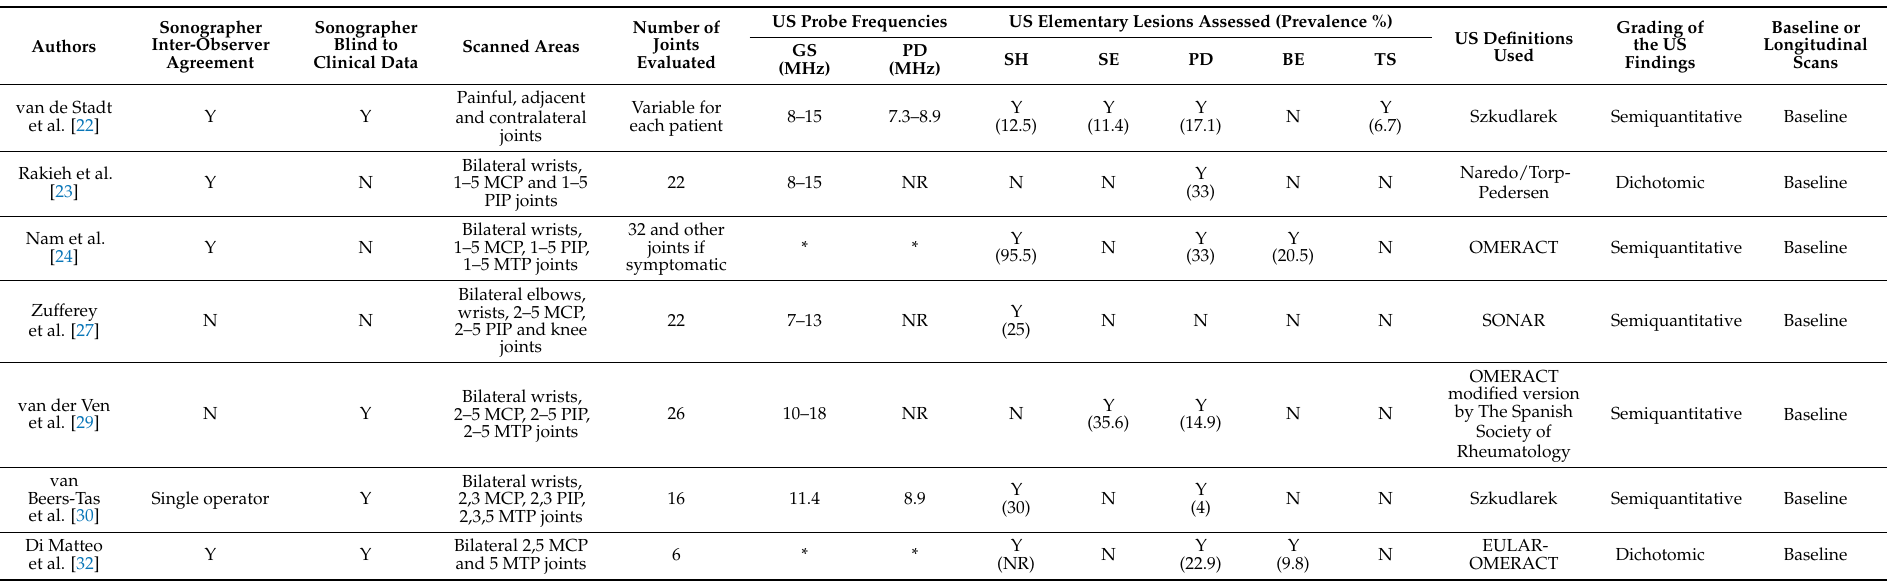
Table 2. Main US-related characteristics of the studies (scanning protocols, definitions and type of US elementary lesions